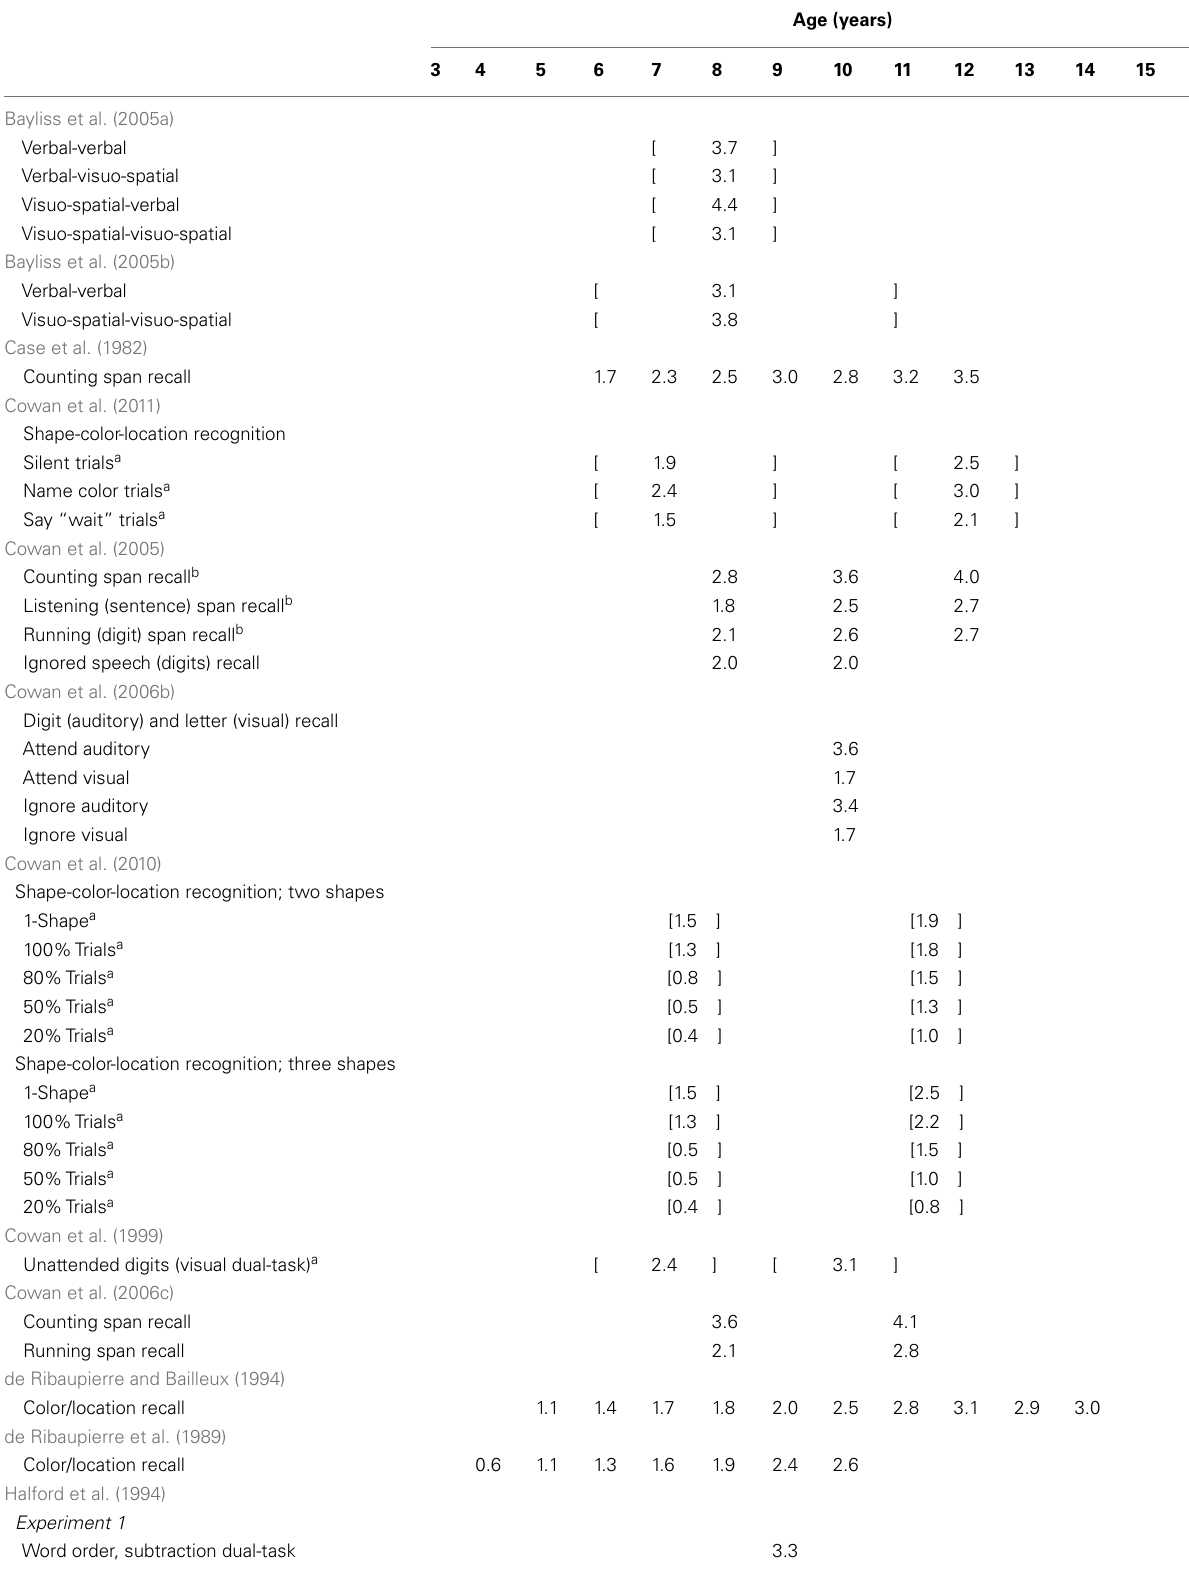
Table 4 | Estimates of working memory capacity using complex and/or